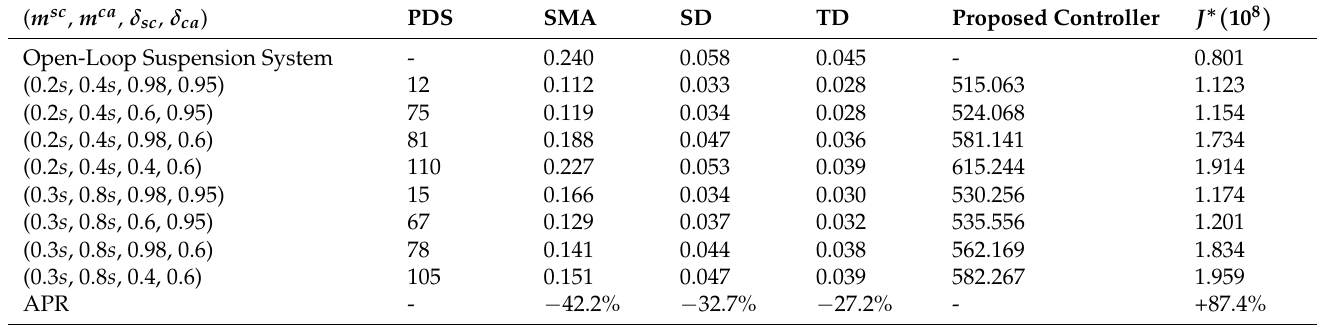
Table 3. RMS values of performance indicators under road roughness with G d ( Ω 0 ) = 256 × 10 − 6 m 3 .